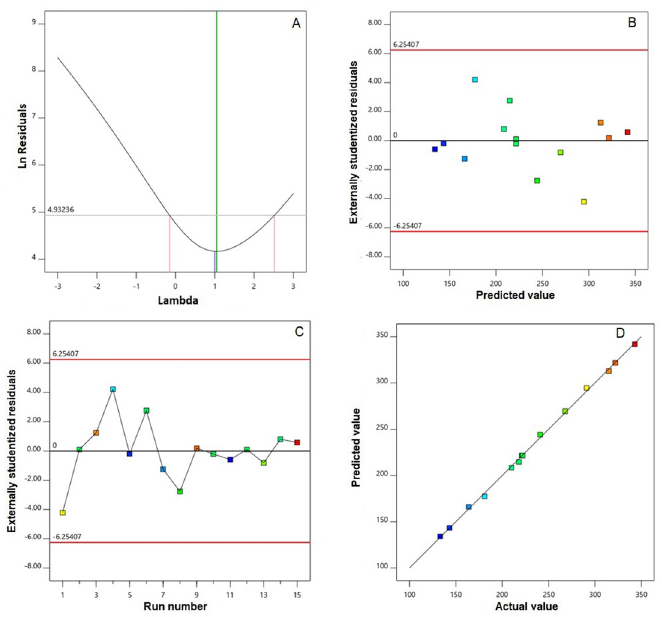
Fig 1. Diagnostic plots for particle size of ALS-MP nanoconjugates: (A) Box-Cox for power transforms, (B) externally studentized residuals vs. predicted particle size, (C) ex-ternally studentized residuals vs. run number, and (D) predicted vs. actual particle size. Abbreviations: ALS, Alendronate sodium; MP, Mastoparan